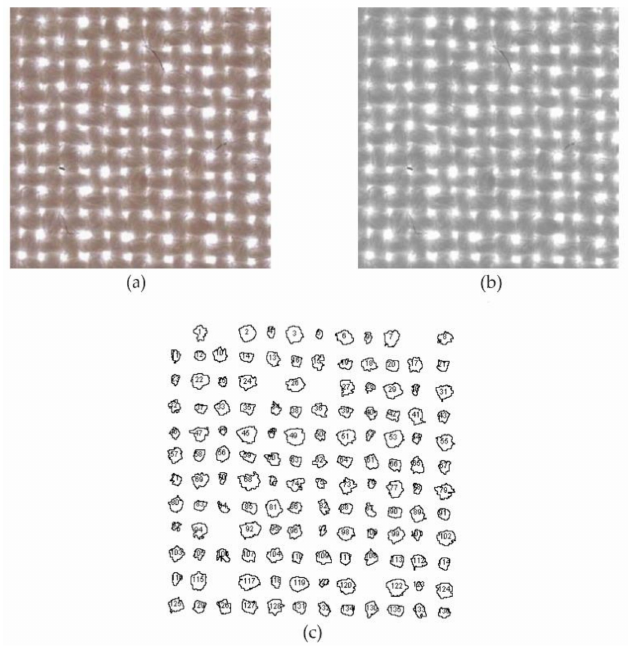
Figure 2. Visually displayed 2, 3, and 4 steps of image processing. ( a ) Image of plain woven fabric cropped on 5 mm × 5 mm; ( b ) the same image after binary transformation; and ( c ) different pore shapes and numbered particle size pores with an area larger than 0.01 mm 2 .